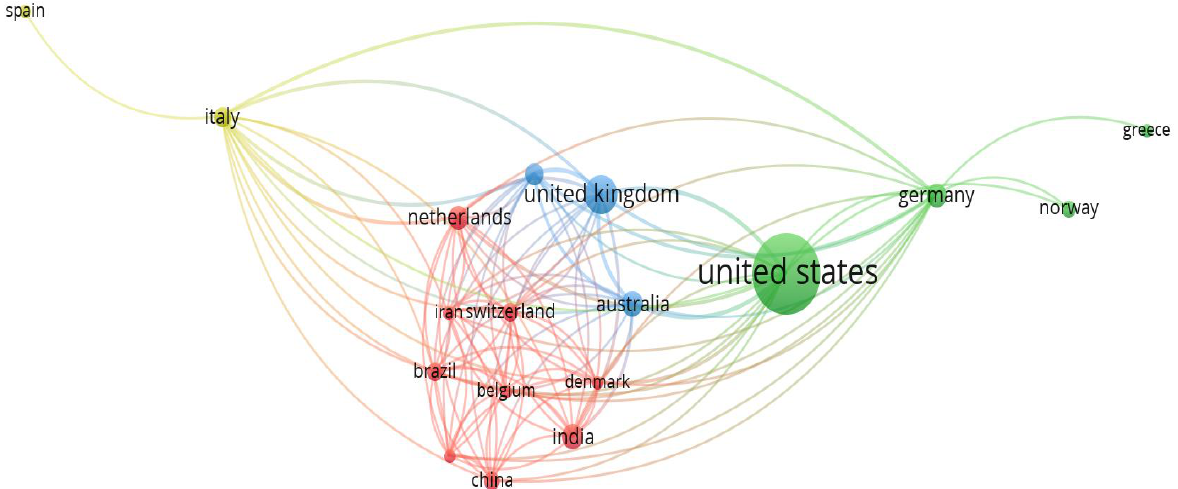
Figure 3. A geographically extensive map of the scientific bibliography of the categories “health care system, medical services, behavioral aspect, social aspect” for 2012-2020 using the VOSViewerv software toolkit.